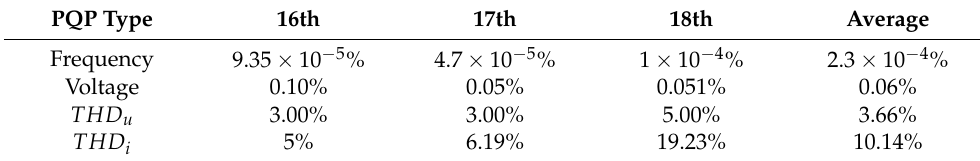
Table 12. Forecasting error (MAPE in%) for 16–18 August 2021, when using the bagging DT.